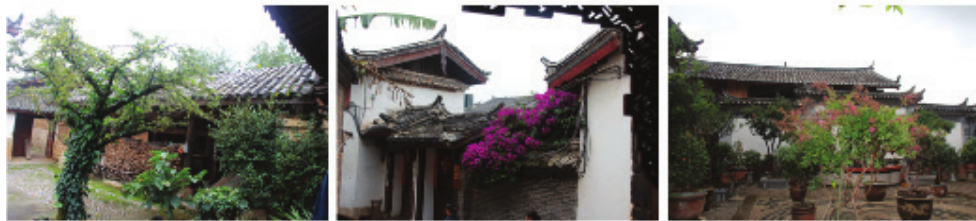
Fig ure 10. Courtyards full of plants (photos by the fi rst author)